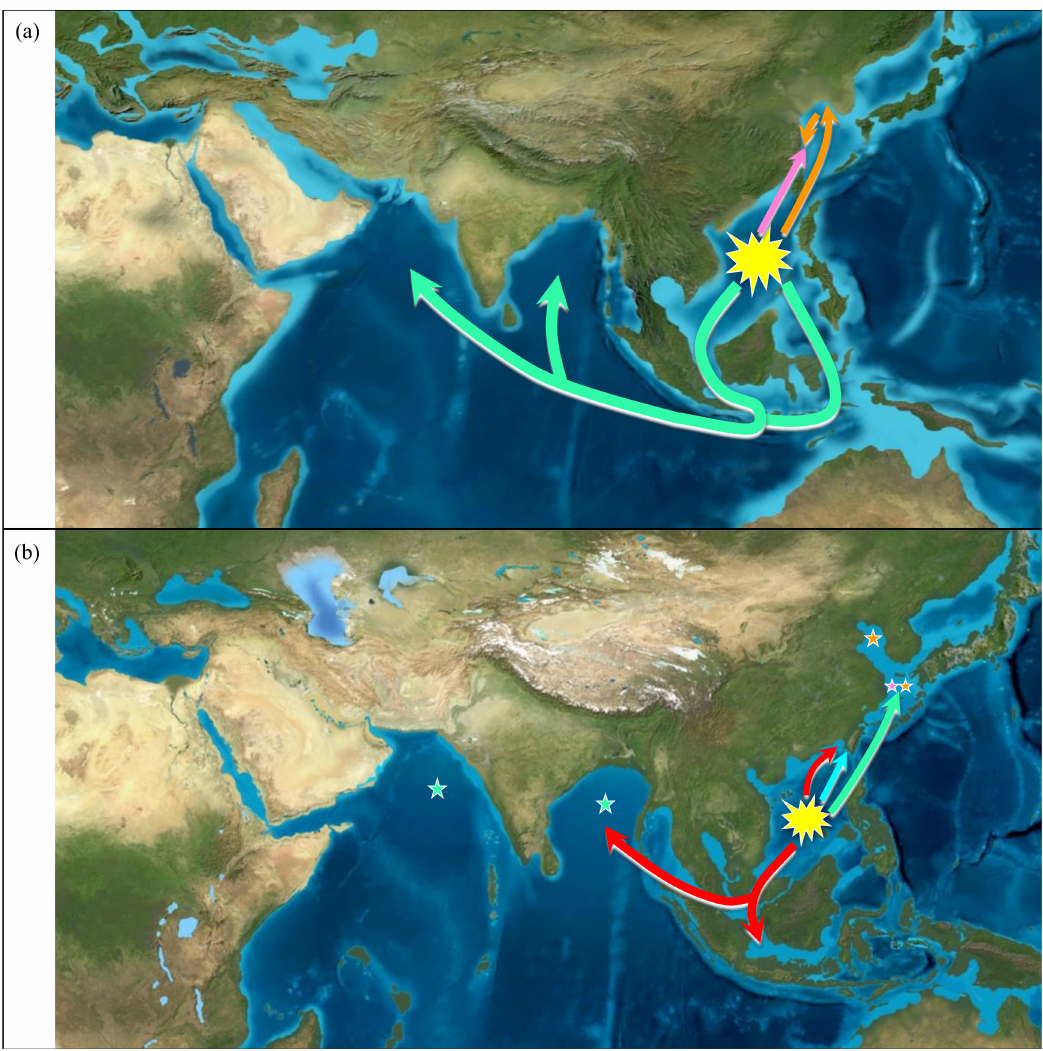
Figure 9. The South China Sea origin of the genus Pampus and dispersal routes of each Pampus species. ( a ) Phase I was 3–5 Mya, ( b ) Phase II was 1–3 Mya. Different-colored arrows represent dispersal routes of different Pampus species: Green, P . cinereus ; Pink, P . punctatissimus ; Orange, P . argenteus ; Red, P . chinensis ; Blue, P . minor . Stars indicate successful colonization in Phase I. Source map © 2020 Colorado Plateau Geosystems, Inc., Scottsdale Arizona, AZ, USA. (License